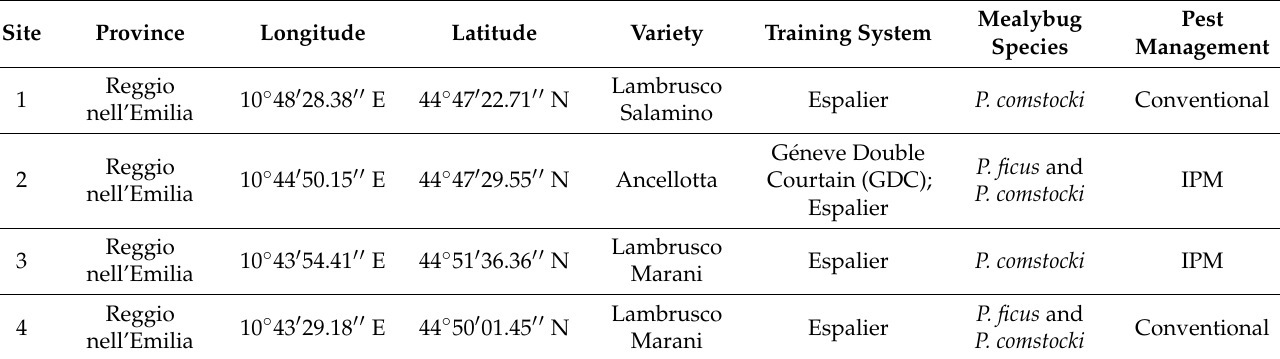
Table 1. Details of the vineyard sites used for the field